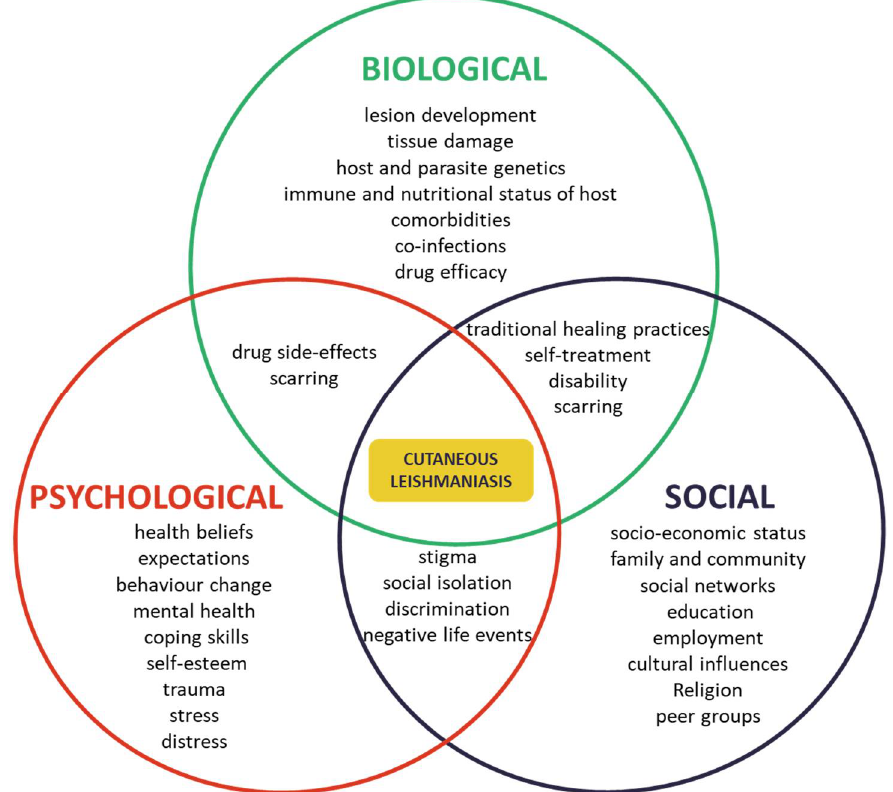
Figure 6. The biopsychosocial model of cutaneous leishmaniasis.